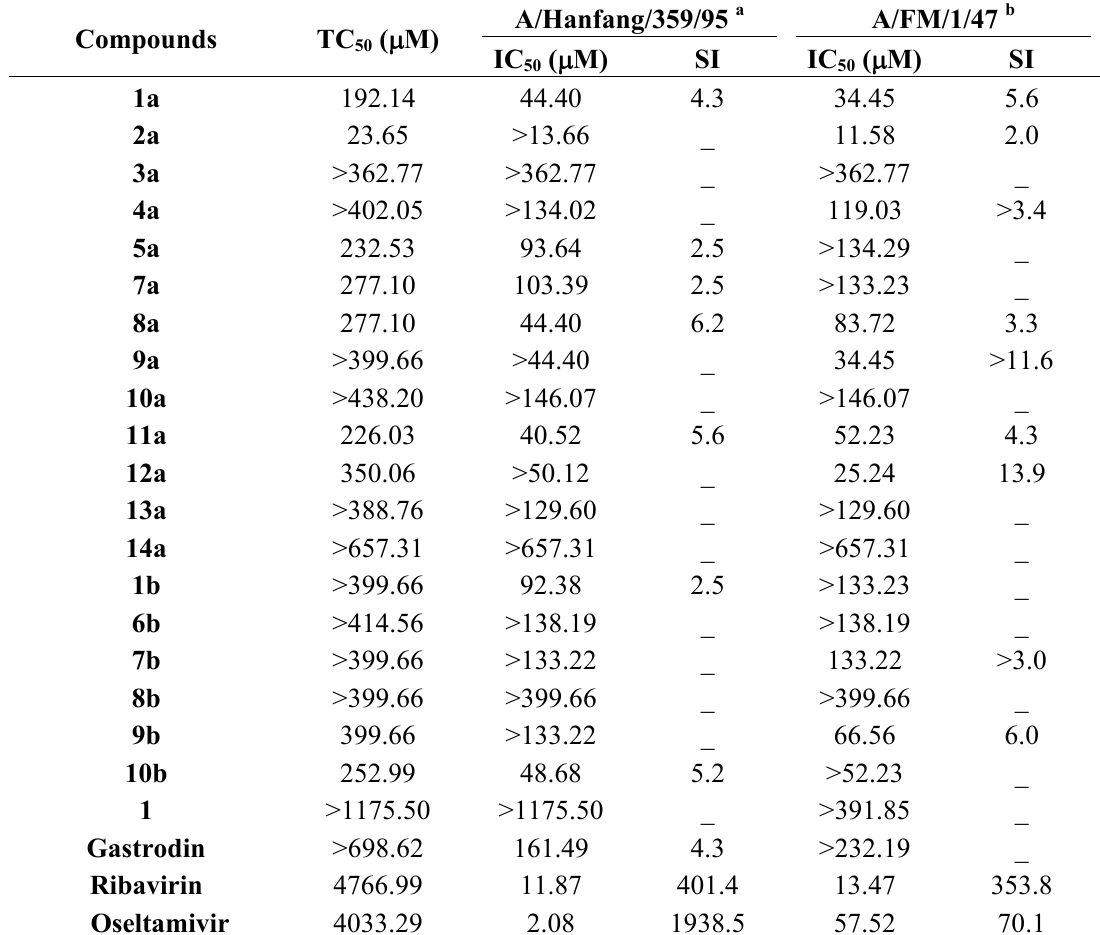
Table 1. Anti-influenza activities of the synthesized